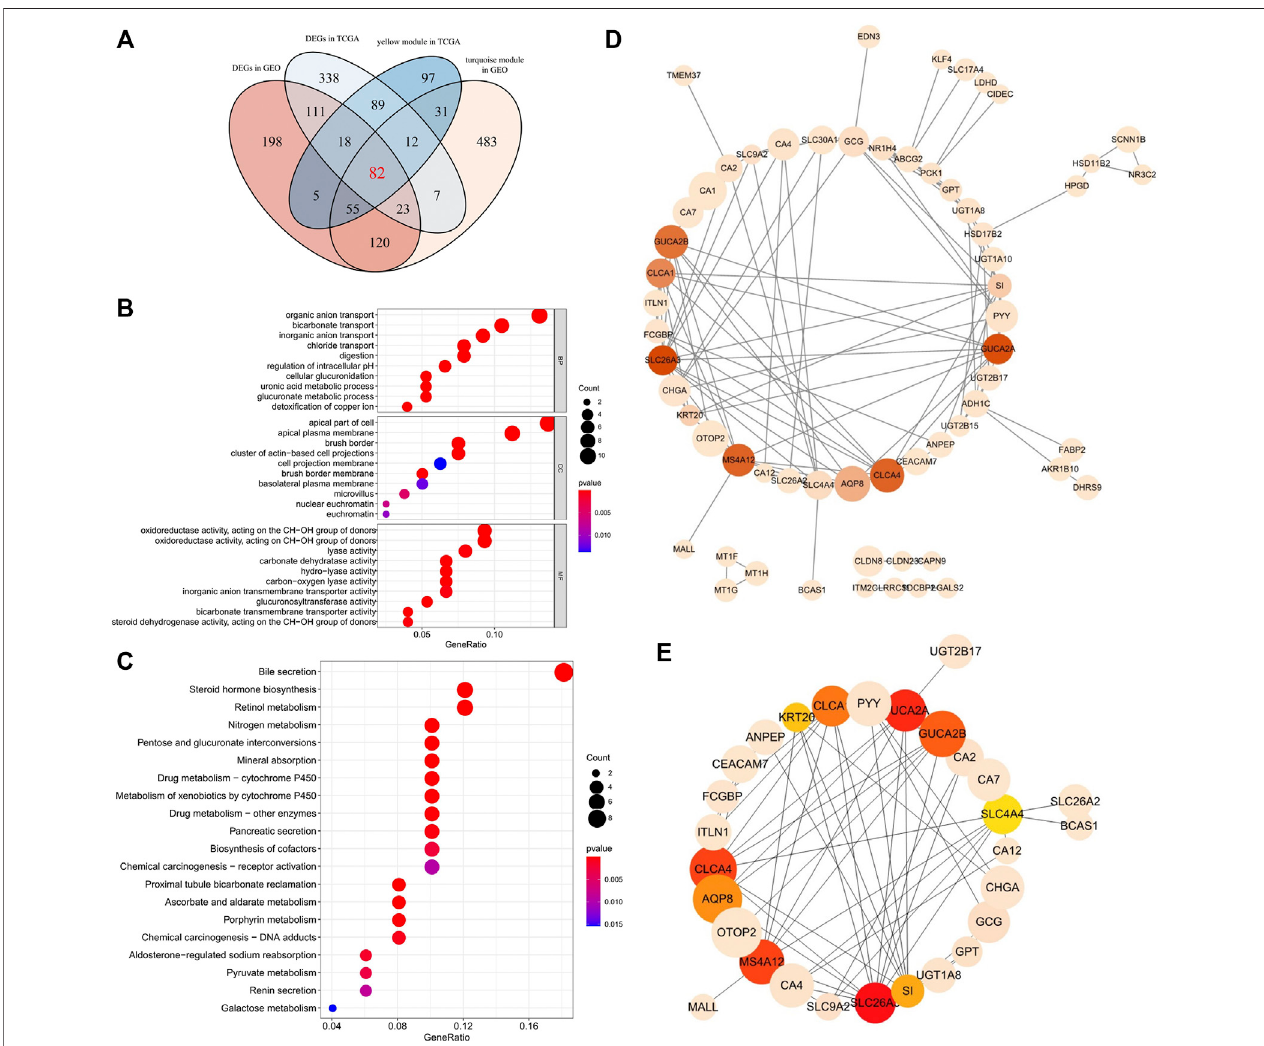
FIGURE 3 | (A) Venn diagram of DEGs and the gene list from the co-expression module. A total of 82 overlapping genes in the intersection of DEGs and two gene listsfromtheco-expressionmodule. (B) GeneOntology(GO)enrichmentanalysisforthe82overlappinggenes.Thecolorofeachbubblerepresentsthe p value,andthe bubblesizerepresentsthenumberofgenes. (C) KEGGpathwaysenrichmentanalysisforthe82overlappinggenes.Thecolorofeachbubblerepresentsthe p value,and the bubble size represents the number of genes. (D) PPI network of the 82 overlapping target genes. There were 82 nodes, where nodes represented genes, and edges were the interactions between two genes. Red is the higher score calculated by the MCC method, followed by yellow, and the size of nodes corresponds to absolute logFC values. (E) A total of 10 hub genes were identi fi ed from 82 genes via MCC algorithm analysis. Network nodes represent proteins; edges represent protein – protein associations. Red is the higher score calculated by the MCC method, followed by yellow, and the size of nodes corresponds to absolute logFC values.